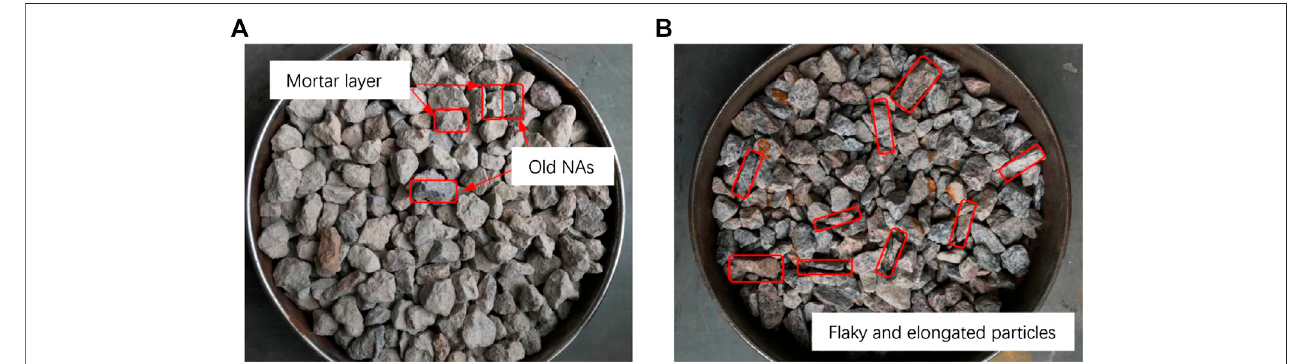
Figure 1 | Coarse aggregate appearance: (A) recycled. aggregates and (B) natural aggregates.